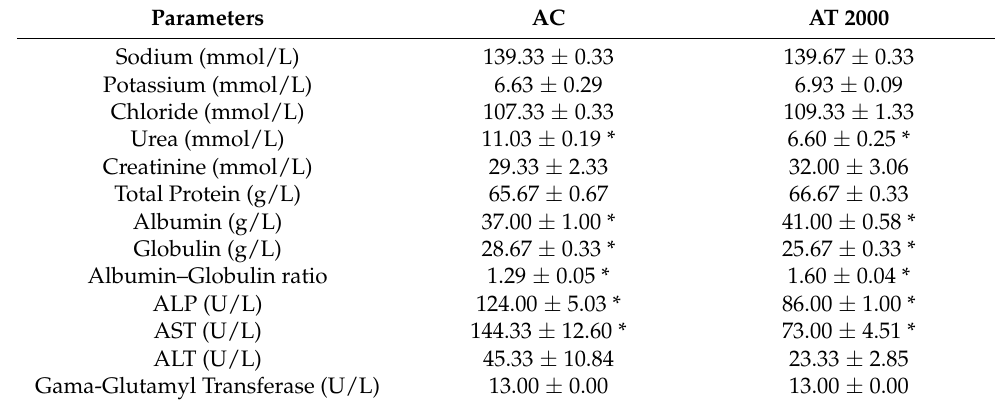
Table 6. Effect of E. tapos 2000 mg/kg yoghurt on blood biochemistry parameters in acute toxicity study. Values expressed as mean ± SEM. (*) indicates a significant difference at p < 0.05.